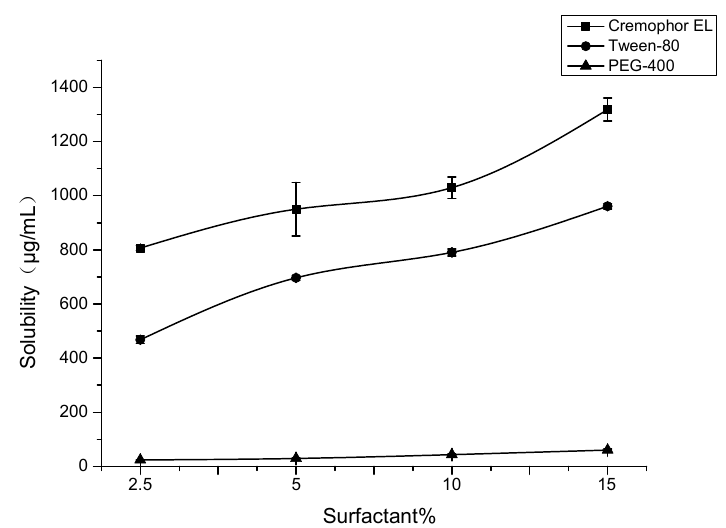
Figure 8. Solubility of SG-PTX in various formulations with different proportion of surfactants (Cremophor EL, Tween-80, and PEG-400). All values are expressed as mean ± SD (n = 4).